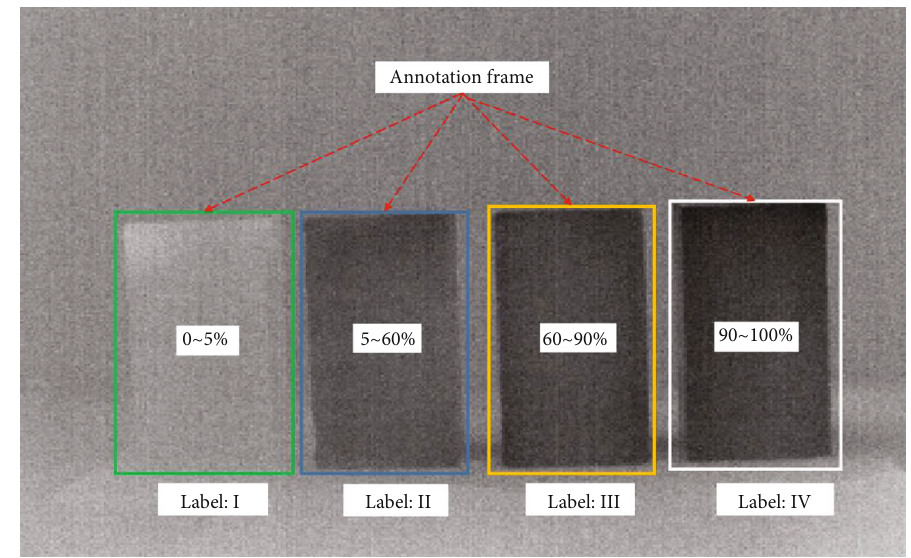
Figure 5: Saturation levels for di ff erent in fi ltration degrees and their corresponding